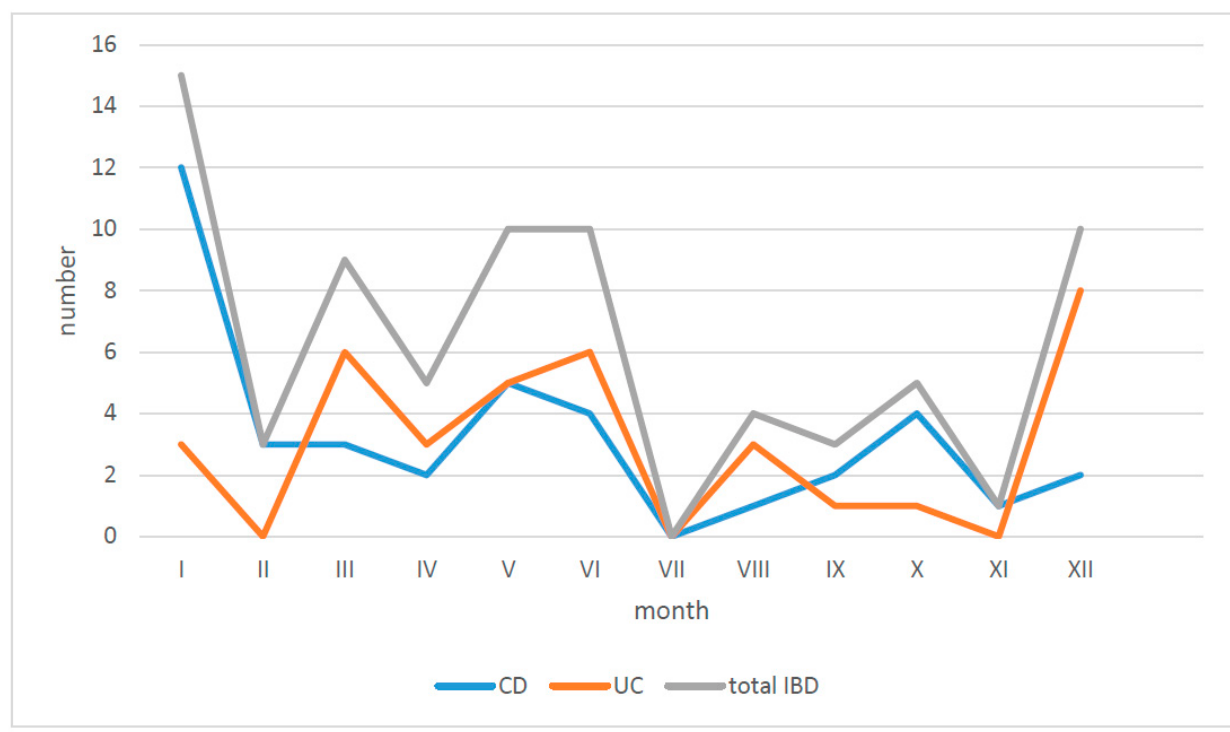
Figure 4. Seasonality of inflammatory bowel disease in children: UC—ulcerative colitis; CD—Crohn’s disease; IBD—